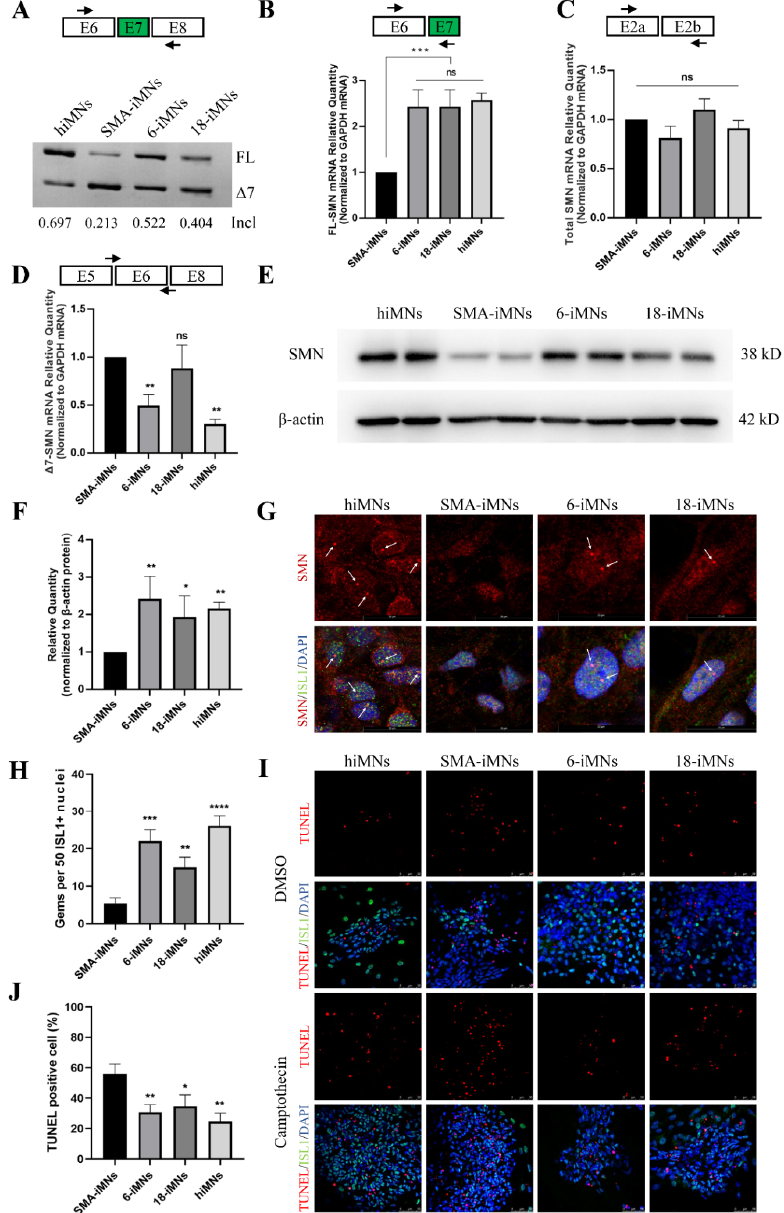
Figure 5. SMN expression in iMNs. ( A ) RT-PCR analysis of SMN2 mRNA in iMNs at day 28. ( B – D ) qRT-PCR analyzed the expression of FL-SMN, ∆ 7-SMN, and total SMN mRNA in iMNs. GAPDH was used as the internal reference. Bars represent the mean ± (SEM); n = 3. Ns, not significant. ** p < 0.01. *** p < 0.001. ( E ) The SMN protein expression levels in hiMNs, SMA-iMNs, and targeted-deletion iMNs (6-iMNs and 18-iMNs). β -actin was used as the internal reference. ( F ) Values for each iMNs were normalized to β -actin protein levels. Data shown indicate mean ± SD. * p < 0.05. ** p < 0.01. ( G ) Immunostaining of SMN in iPSCs derived iMNs. The red fluorescence showed SMN protein, and the gems were pointed out with white arrows. The green fluorescence indicated ISL1. DAPI was used to visualize the nucleus. ISL1, ISLET1. ( H ) The number of gems detected was higher in the hiMNs, 6-iMNs, and 18-iMNs compared with SMA-iMNs. Data shown indicate mean ± SD. ** p < 0.01. *** p < 0.001. **** p < 0.0001 ( I ) MNs were treated with DMSO or 10 µ M camptothecin for 21 h and assayed with TUNEL to mark apoptotic cells. DAPI was used for nuclear staining. ISL1, ISLET1. ( J ) Quantification of TUNEL positive iMNs to total cells after camptothecin treatment. Data shown indicate mean ± Sd. n = 3. * p < 0.05. ** p <